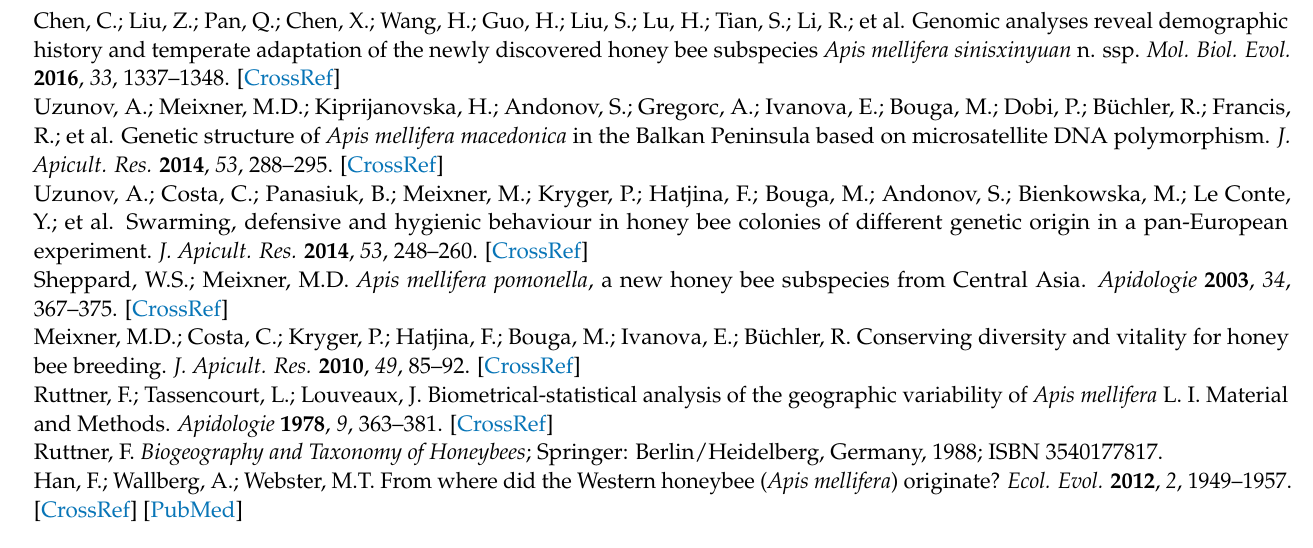
given, Table S3: Comparison of acquisition curves. Test statistics for Sidak post hoc tests are